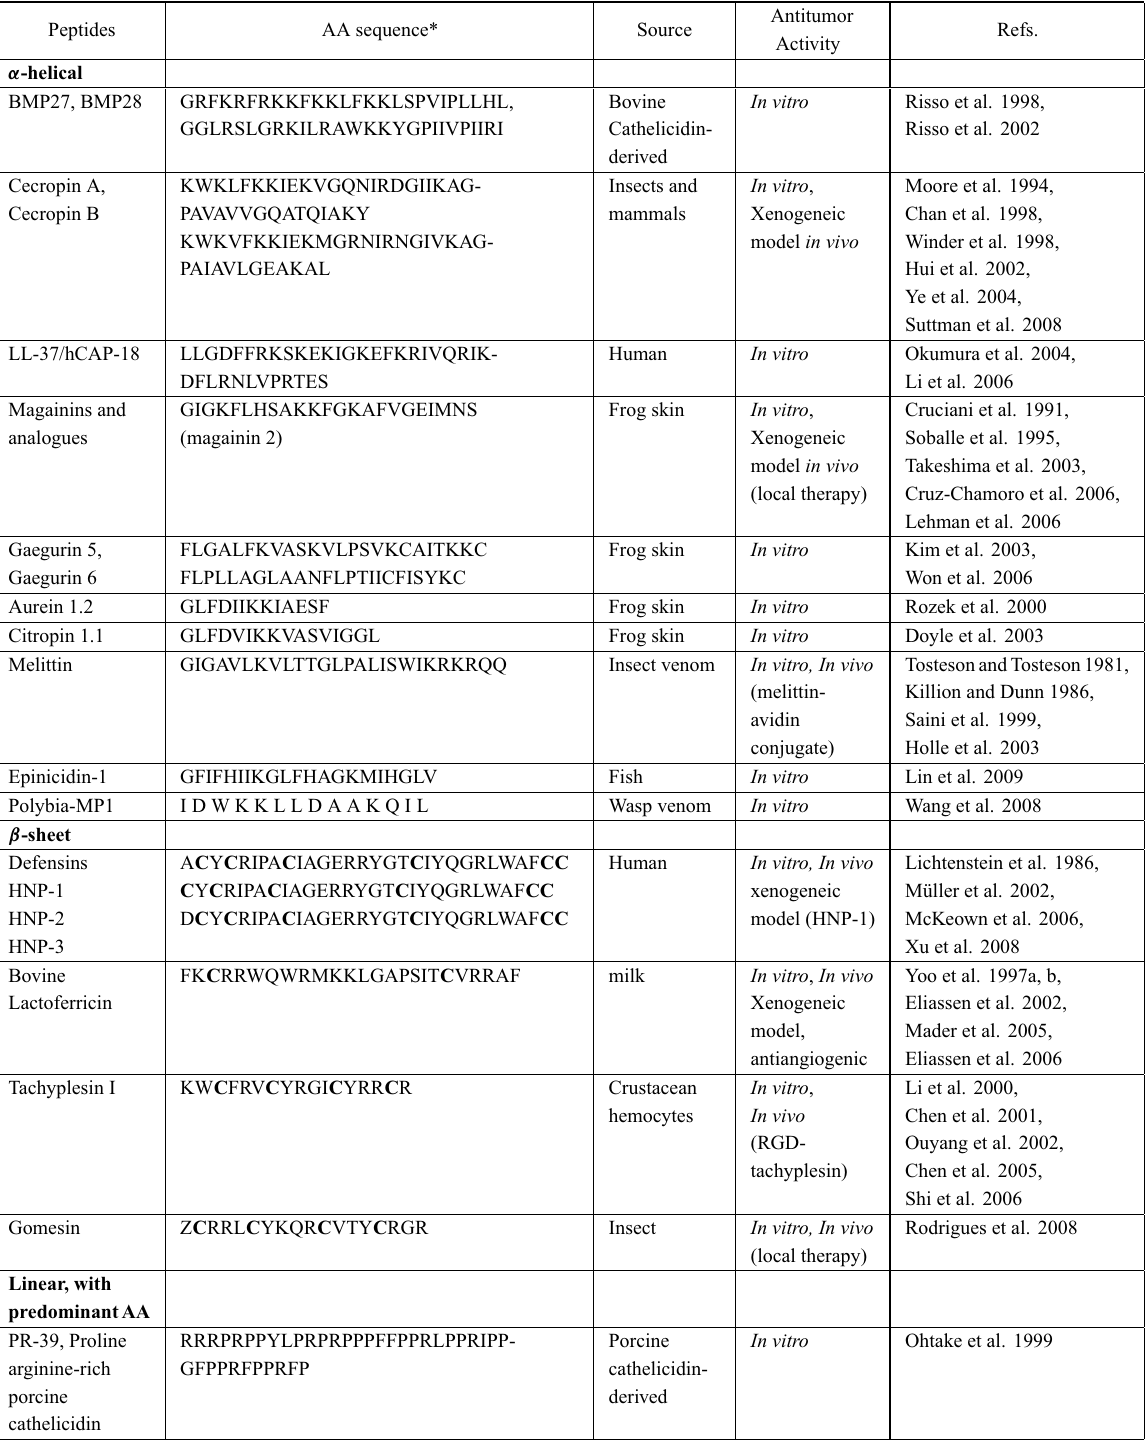
Naturally occurring CAPs with antitumor